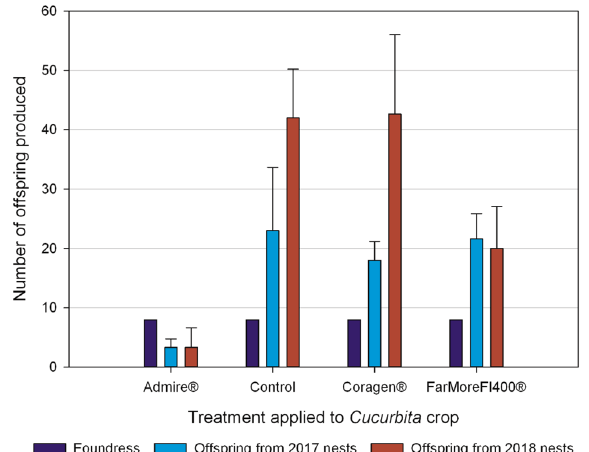
Figure 3. Number of hoary squash bee offspring from nests established by mated female bees in 2017 and 2018. In 2017, eight mated foundress hoary squash bee females were introduced into each hoop house in which one systemic insecticide treatment (either Admire-imidacloprid, applied to soil at seeding; or Coragen- chlorantraniliprole applied as a foliar spray; or FarMore FI400-thiamethoxam applied as a seed treatment) was applied to the squash crop (Varieties: Table Star (2017), Celebration (2018)) 8-weeks before bee active period, or the crop remained untreated as a control. Data presented are means ± SE across three hoop houses per treatment in each